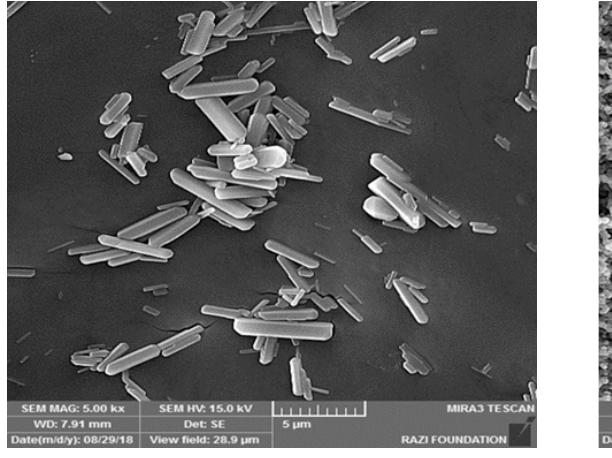
a b Figure 10. SEM micrographs of the ferrous sulfate before (a) and after (b) coagulation